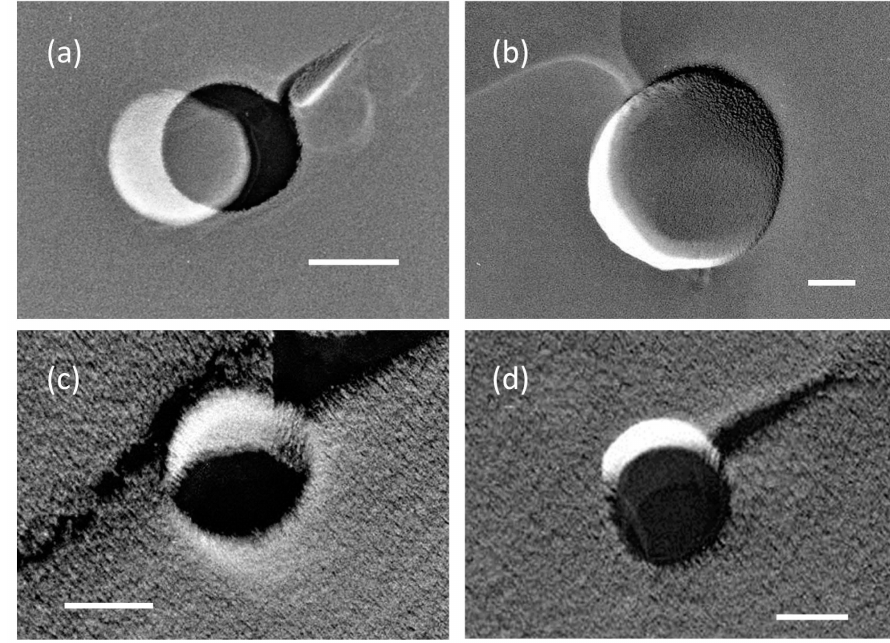
Figure 1. Transmission electron microscopy (TEM) images of micro- and nanobubbles (MNBs) in ( a , b ) 10 mM and ( c , d ) 100 mM NaCl solutions. Each scale bar shows 100 nm. A bubble hole was sometimes covered with thin film (relatively brighter image) formed inside of the hole.